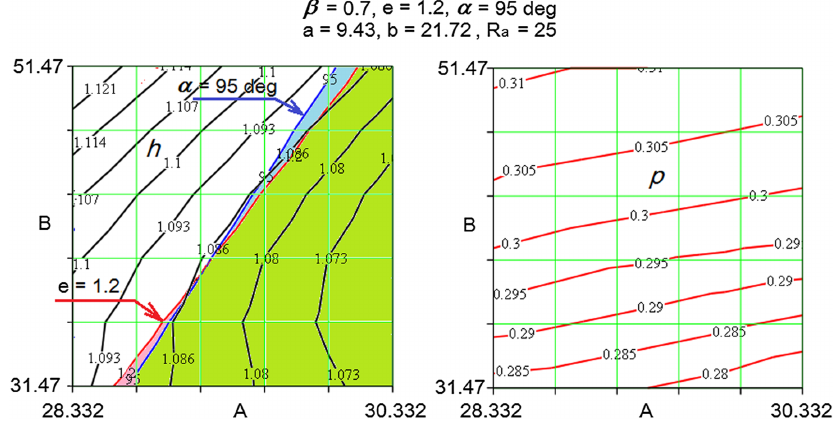
FIG. 16. Map for one of the points from Fig. 21 for β ¼ 0 . 7 . Wide choice of A and B keeping the optimal h . A possibility to get rid of multipactor choosing p < 0 . 3 .